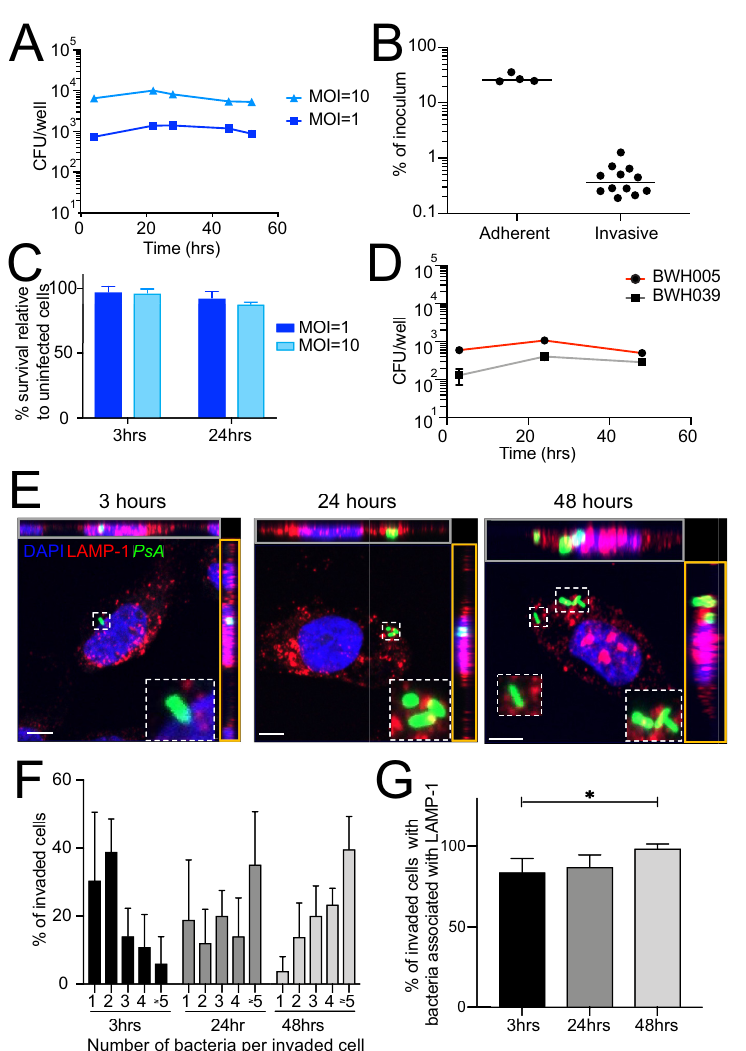
Fig 1. Pseudomonas aeruginosa survives intracellularly. A gentamicin protection assay was used to quantify intracellular bacterial burden. (A) Cells were infected with WT PAO1 at MOI = 1 or 10. (B) Host cell survival at 3 and 24 hpi with WT bacteria at MOI = 1 or 10 relative to uninfected cells harvested at the same time point. (C) Cells were infected at MOI = 1 with two clinical strains (BWH005 and BWH039) which were isolated from urine. (D) Cells were infected at MOI = 10 for 2 hours and incubated in the absence, to measure adherent bacteria, or presence of gentamicin, to measure invading bacteria, and harvested at 3 hpi. (E-G) Cells were infected with WT GFP-expressing bacteria at MOI = 10, fixed at the indicated time points and stained with anti-LAMP-1 antibodies and DAPI. (E) Representative images of invaded cells. Maximum intensity projections of XY (middle), and orthogonal XZ (gray outline) and YZ (orange outline) projections of the serial confocal images are shown. Scale bar = 5 μ m. (F) Intracellular bacterial load as determined by microscopy. (G) Percent of invaded cells with LAMP-1-associated bacteria. Data is representative of 4–6 biological replicates with at least 50 cells per condition. Error bars represent standard deviation. Data were analyzed by one-way ANOVA (p = 0.02). the cytotoxicity observed for PAO1 in other host cell types [19], PAO1 did not result in decreased survival of 5637 cells at 3 and 24 hpi compared to uninfected control cells (Fig 1C).